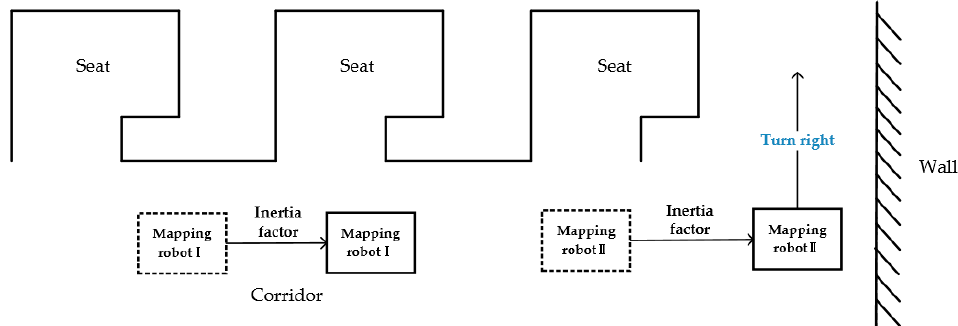
Figure 9. Theoretical path diagram after modifying the algorithm.